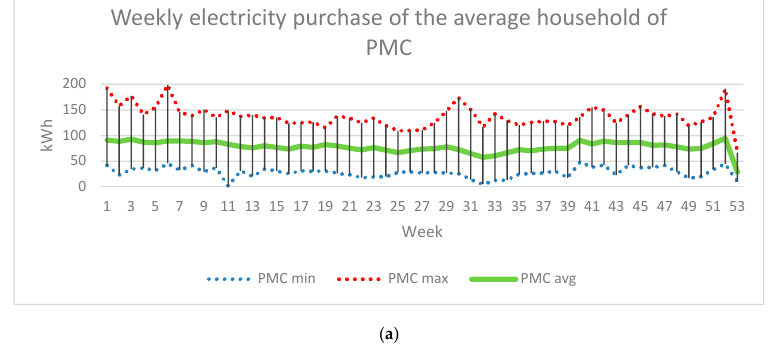
* according to the production subtracted from the mean consumption value.